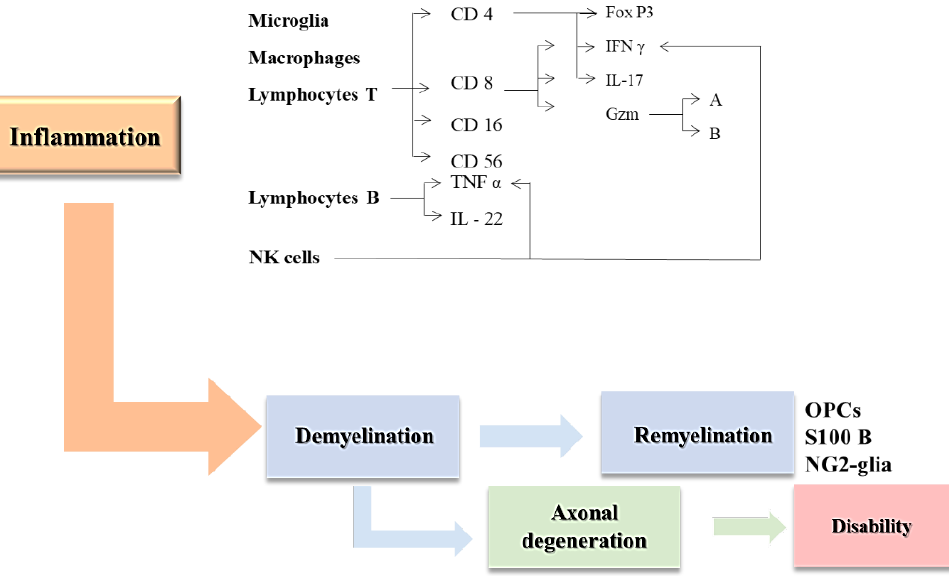
Figure 1. “Outside-in” theory (details in the text)-cells and processes Figure 1. “ Outside-in ” theory (details in the text)-cells and processes involved. CD4 T cells are identified in the cerebrospinal fluid (CSF) of MS patients and deep